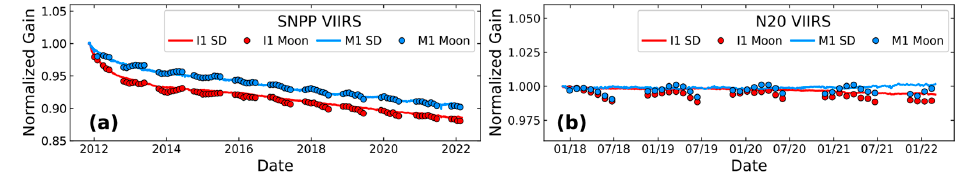
Figure 4. ( a ) SNPP and ( b ) N20 VIIRS SD and Lunar gain trending for bands I1 and M1.